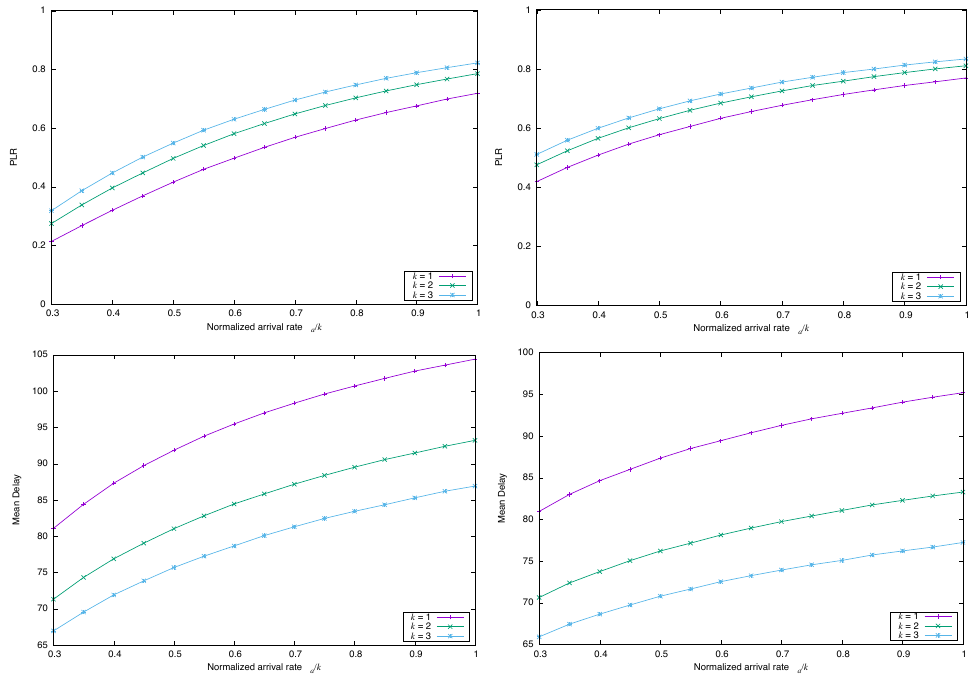
Figure 5. Simulated PLR ( top ) and Mean Delay ( bottom ) for FS-CSA versus λ a / k , with Λ ( x ) = 0.86 x 3 + 0.14 x 8 , n = 200 and k = { 1,2,3 } , and marginal distribution Lognormal, with σ 2 = 1.1 µ 2 ( left ) and σ 2 = 4 µ 2 ( right